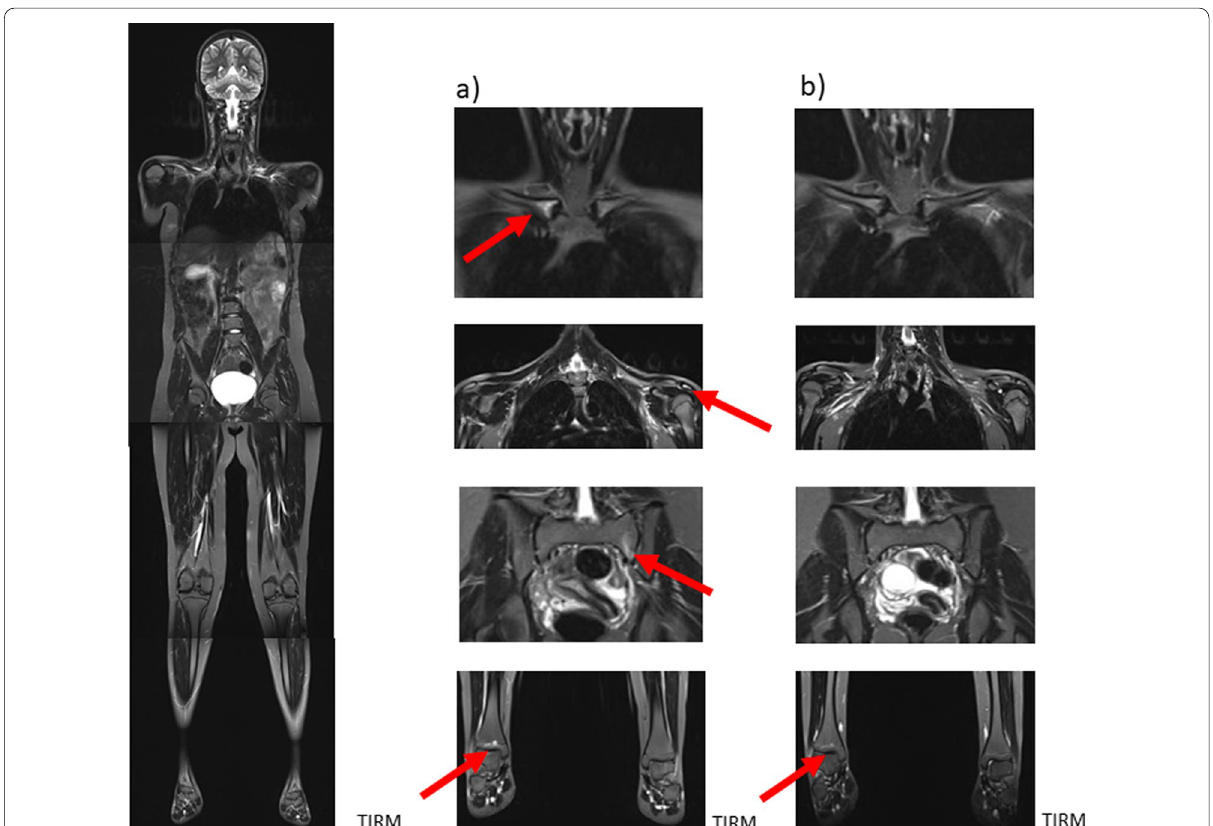
Fig. 6 A 12-year-old girl, multifocal CNO. Whole-body MRI (left column) with (foci in the right clavicle, left acromion, left pars lateralis ossis sacri and distal right tibia (enlargements in the middle column). After therapy with naproxen and pamidronate, subtotal regression of the foci (right